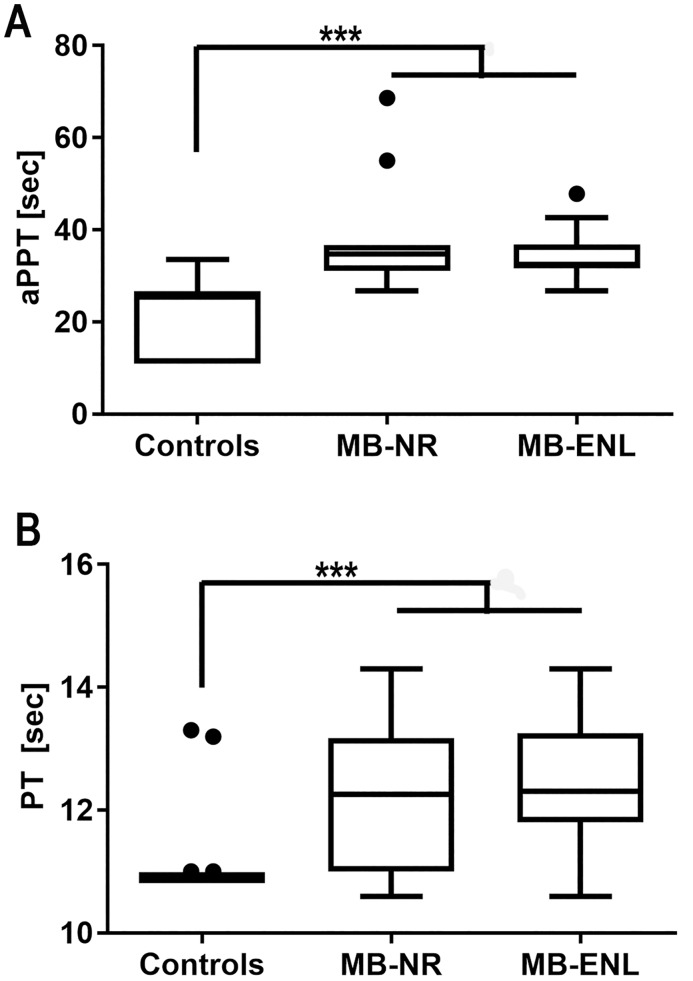
Multibacillary leprosy patients present prolonged coagulation time in both coagulation pathways.Coagulation times were determined on plasma from 50 non-leprosy patients (Controls), 9 non-reactional multibacillary patients (MB-NR) and 15 multibacillary erythema nodosum leprosum patients (MB-ENL). A) Activated partial thromboplastin time test (aPPT); B) prothrombin time test (PT). MB-NR group are composed by 10LL and 1 BL patients. MB-ENL group are composed by 13 LL and 1 BL individuals. Neither of them presented the leprosum clot during serum harvesting. All patients’ details are listed in S1 Table. *** indicate p<0.0001 with ANOVA.